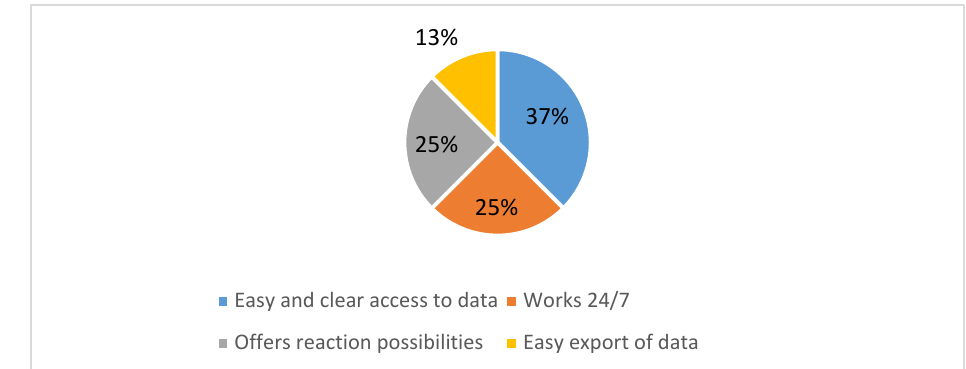
Figure 8. The advantages of the current FMIS.